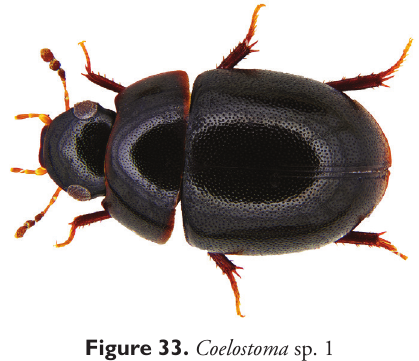
Figure 33. Coelostoma sp. 1 4.5 mm, iSimangaliso Wetland Park, Catalina Bay (site 32), February 2015 DT Bilton, MS Bird & R Perissinotto leg.